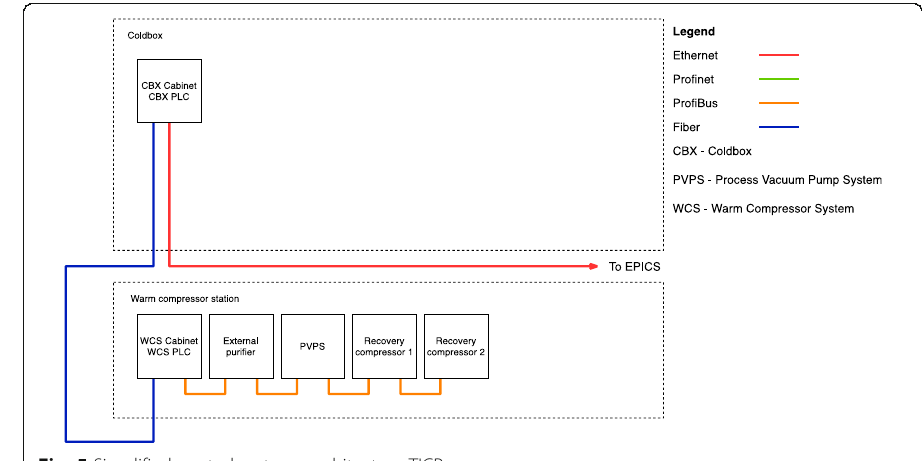
Fig. 5 Simplified control systems architecture TICP